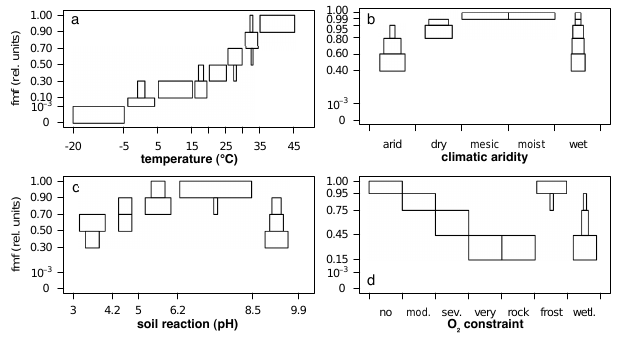
Figure 2. Probability distribution of four fraction modifying factors (fmf). Box width within each class of decomposition fraction con- trolling variable ( x axis) is proportional to probability of the class of the fraction modifying factor. O 2 constraint labels: no, moderate, severe, very severe, rock or bare, permafrost, wetland. Note that the y axes are not